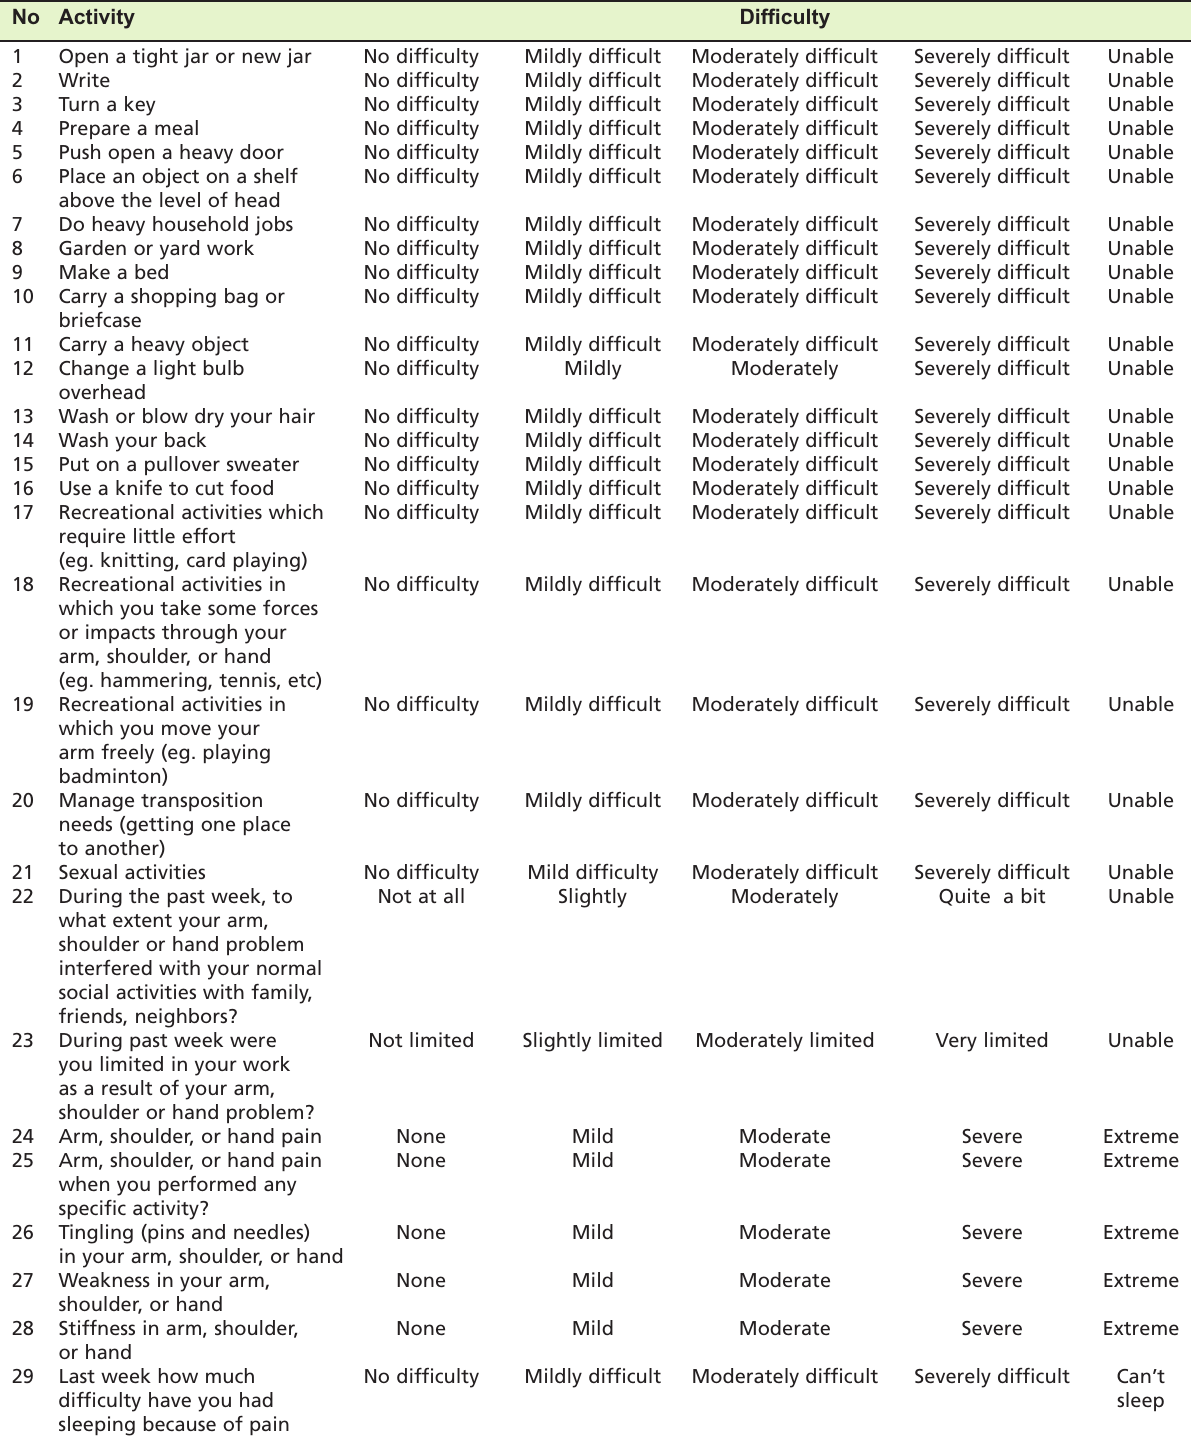
DASH score for shoulder, elbow and Table II: